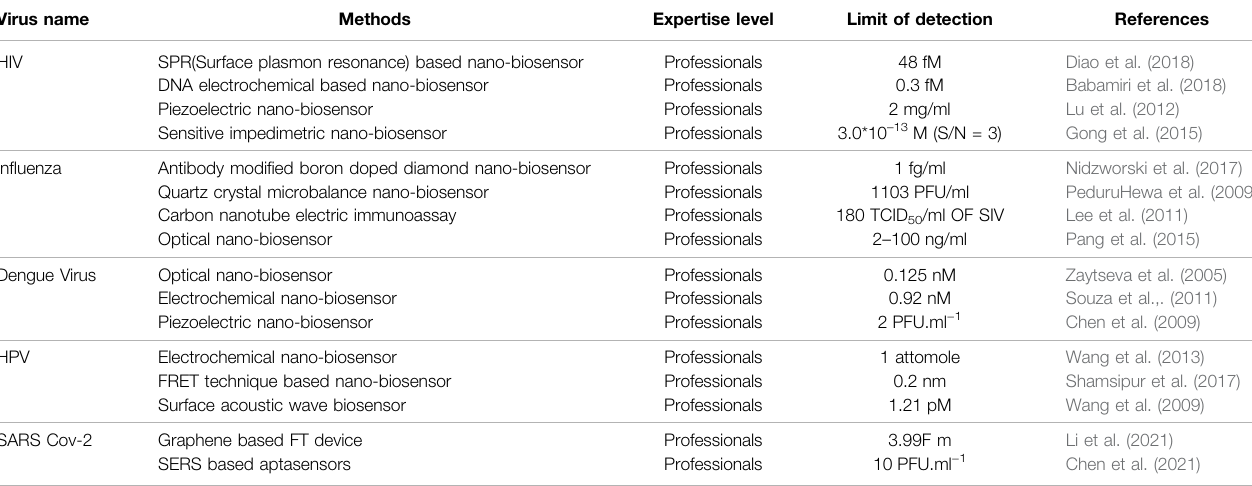
TABLE 1 | Different biosensors for the detection of Viruses and their